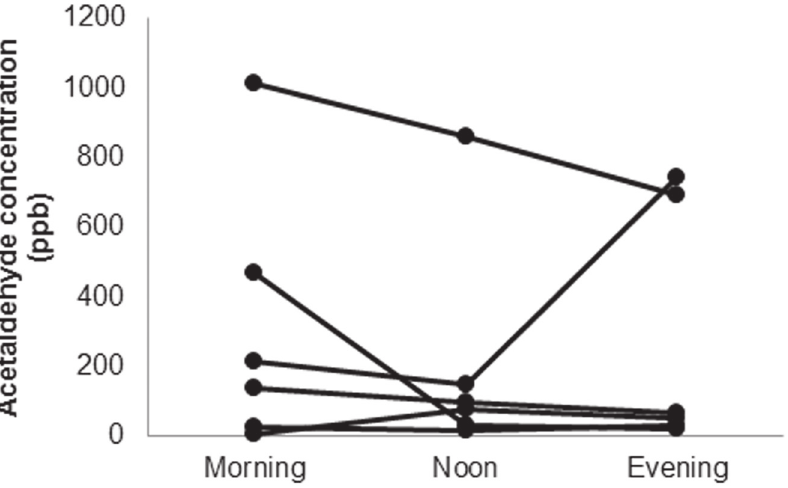
Figure 3- Diurnal variation in acetaldehyde concentration (morning, noon and evening). Acetaldehyde concentration did not present significant diurnal variations (Wilcoxon signed rank test, p>0.05,